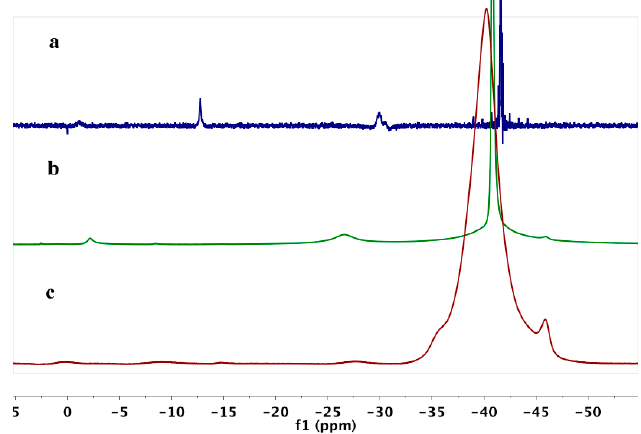
Figure 1. 11 B NMR spectra of Mg(BH 4 ) 2 ·THF (tetrahydofuran) dehydrogenated ( a ) solution phase dissolved in 1:2 THF:D 2 O, ( b ) solid state collected at 160 °C and ( c ) solid state collected at 20 °C. Experimental set-up described in references [35,36].